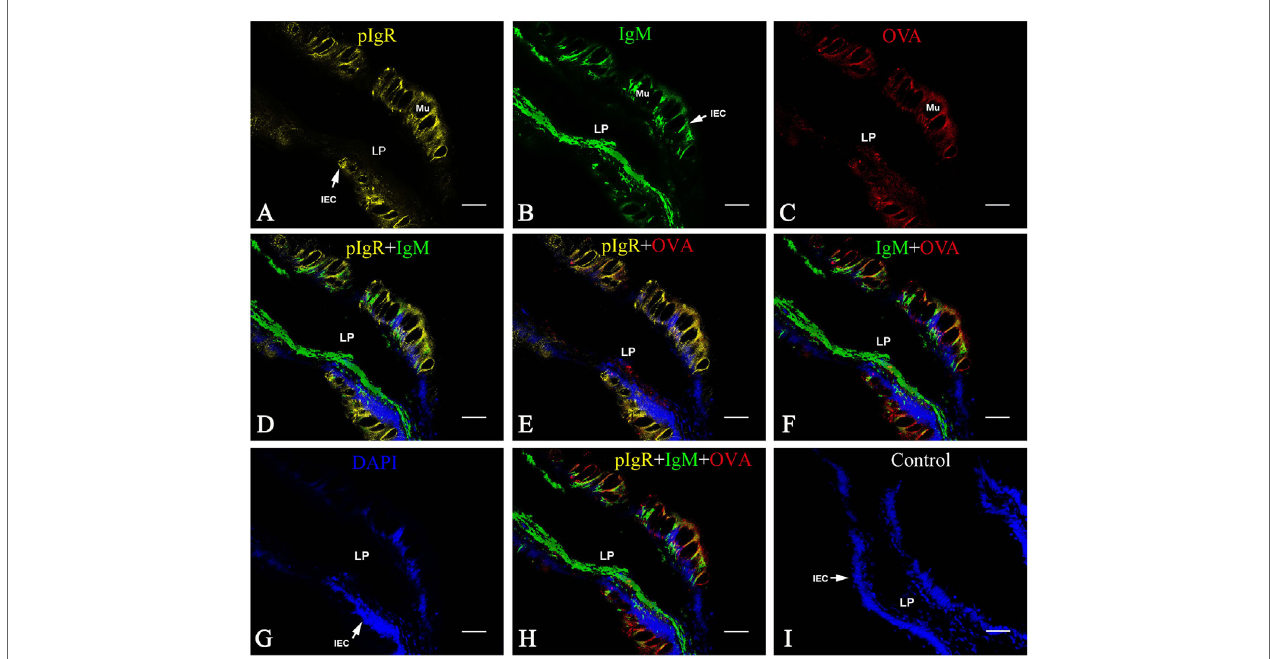
FigUre 5 | Co-localization of pIgR, IgM, and OVA in hindgut of flounder. Pictures from group 1 were shown as examples. The fish immunized intraperitoneally with OVA and subsequently challenged with OVA via caudal vein on the fourth week after immunization, and pIgR, IgM, and OVA in hindgut was stained at 2 h after challenge, presenting orange, green and red fluoresce respectively. The cell nucleus was counterstained in blue with DAPI. (a,B,c) Distribution of IgM, OVA, pIgR in hindgut at 2 h after challenge was illuminated, respectively. (D–F) The merged picture of (a,B,g) and (a,c,g) and ( B,c,g) , respectively. (g) The cell nucleus of intestinal epithelium was stained blue by DAPI. (h) The merged picture of (a–c,g) ; (i) Negative control. Bar = 25 µm. Abbreviations: LP, lamina propria submucosa; Lu, lumen; IECs, intestinal epithelial cells; Mu, mucus cells; BV, blood vessel; OVA,